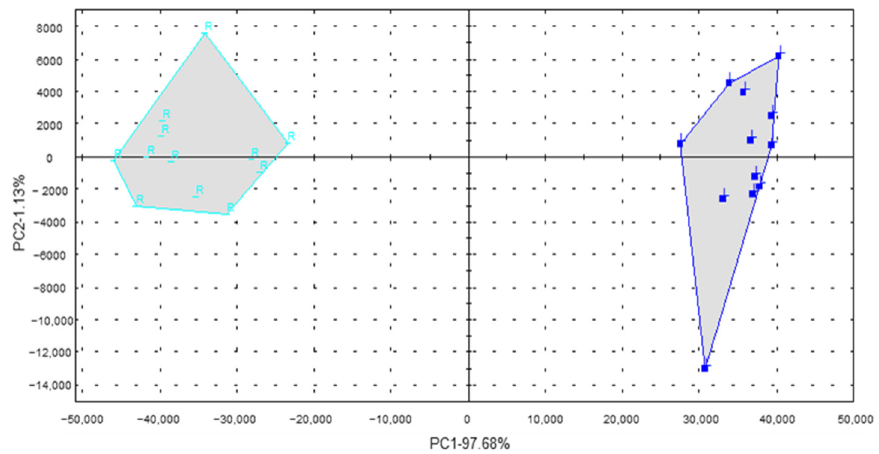
Figure 3. PCA of aroma compounds in the pre- and postrigor roasted mutton by flash GC e-nose. R and L represented the prerigor roasted mutton and postrigor roasted mutton,